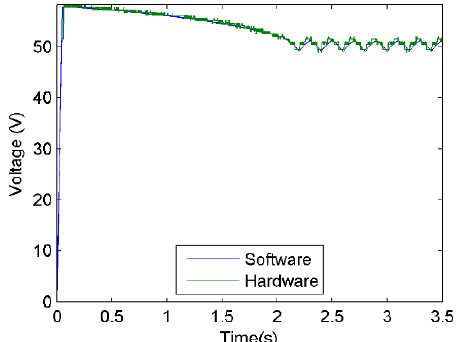
Figure 27. PVPE current response with the MPPT controller emulator.